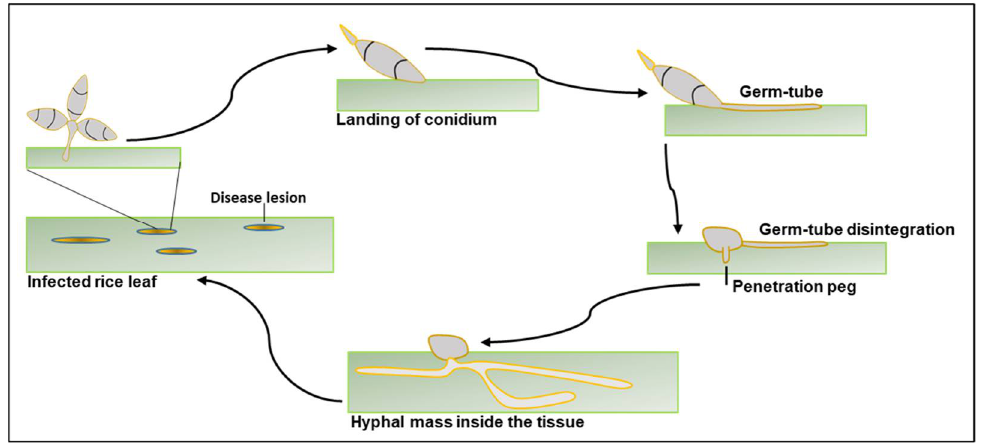
Figure 1. Schematic representation of the life cycle of the M. oryzae in rice.